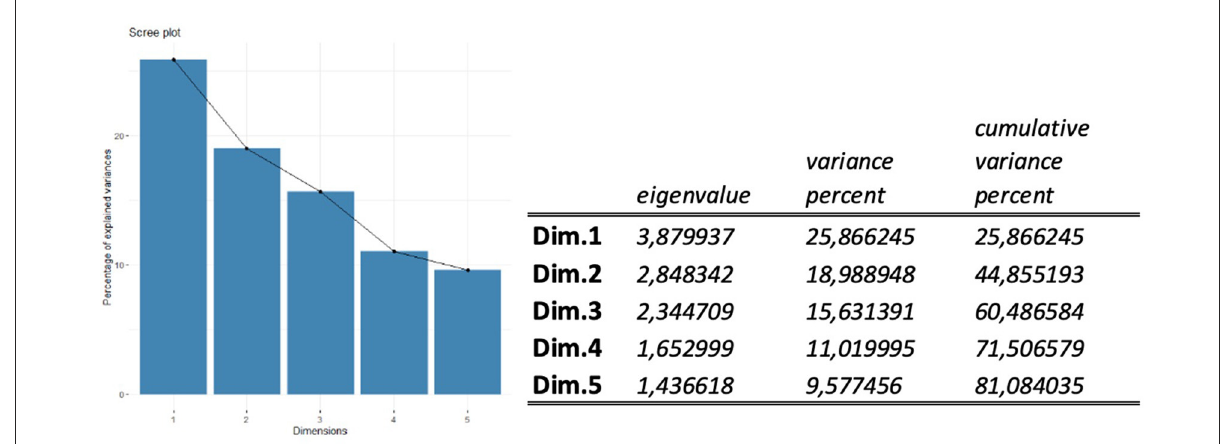
FIGURE5 Percentage of inertia explained by each FAMD dimensions. SDOH and DM variables.